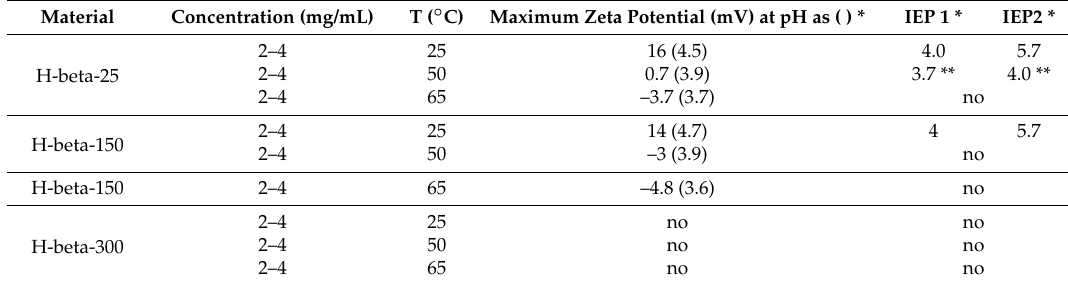
Table 4. Zeta potential values for beta zeolites.